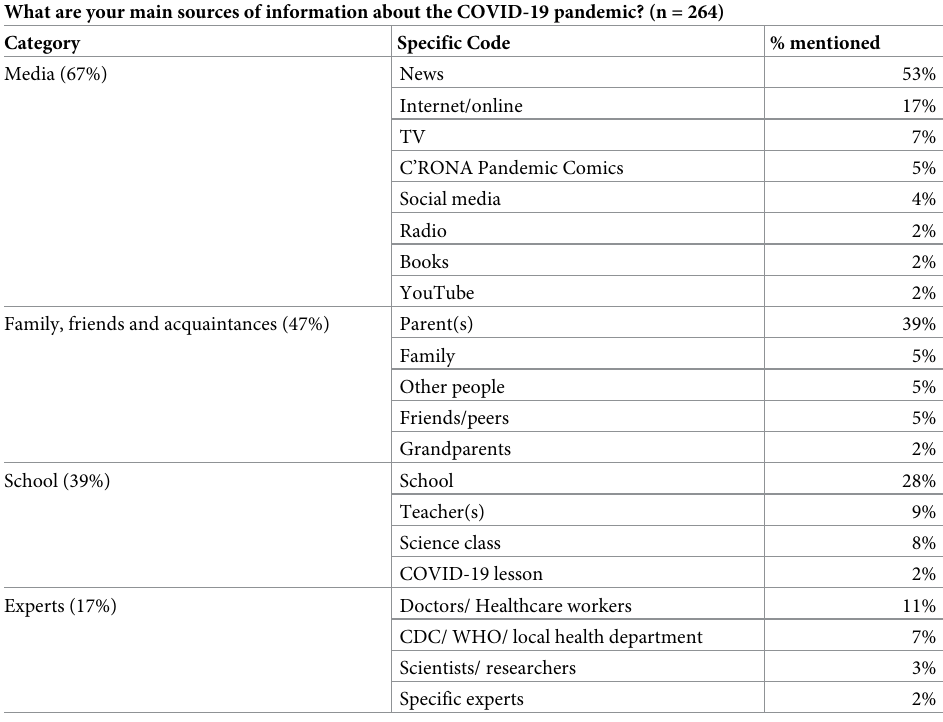
Table 1. Sources of information about the COVID-19 pandemic (N =